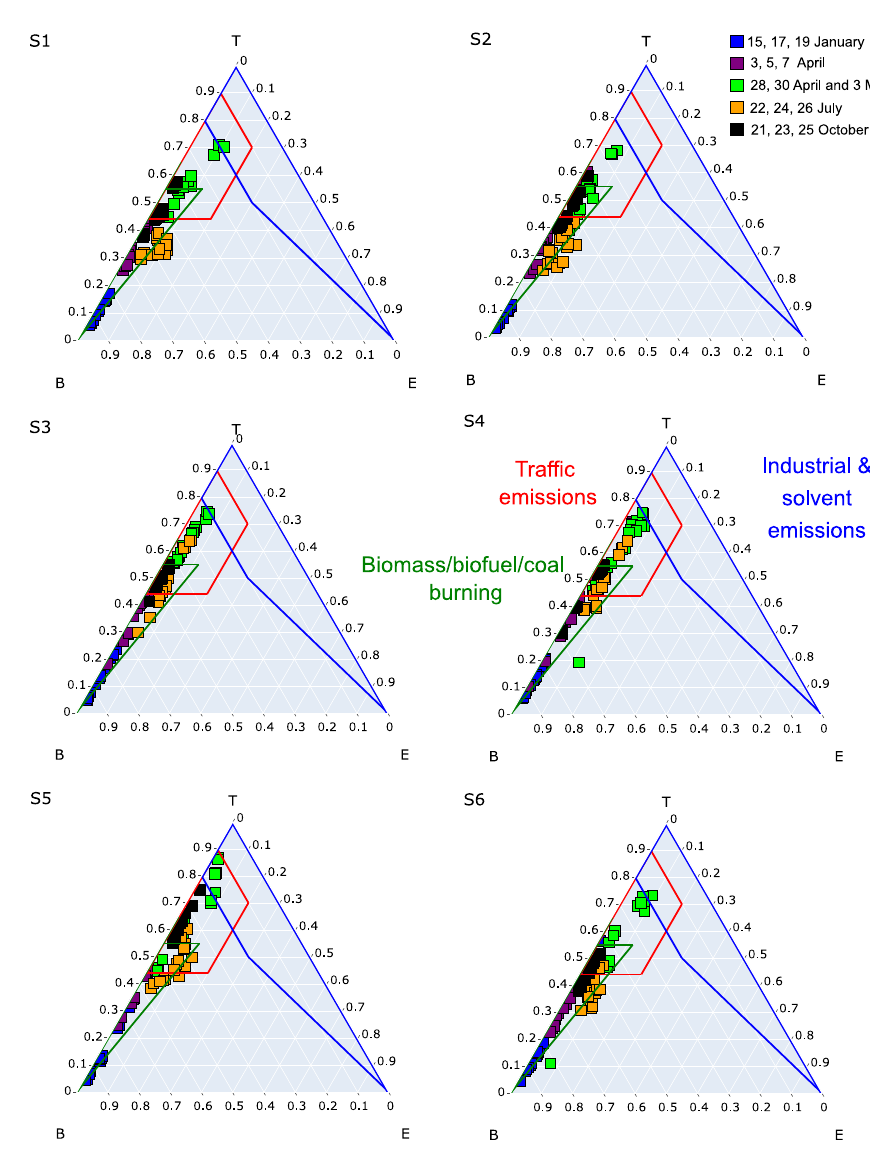
Figure 6. Benzene:Toluene:Ethylbenzene ratios in